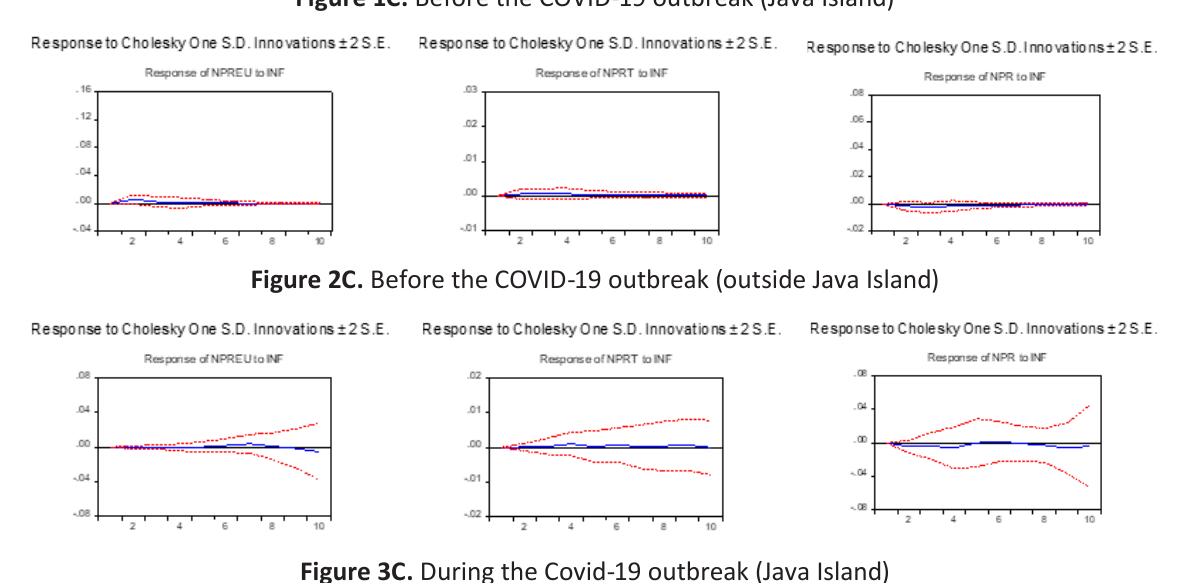
Figure 1C. Before the COVID-19 outbreak (Java Island)